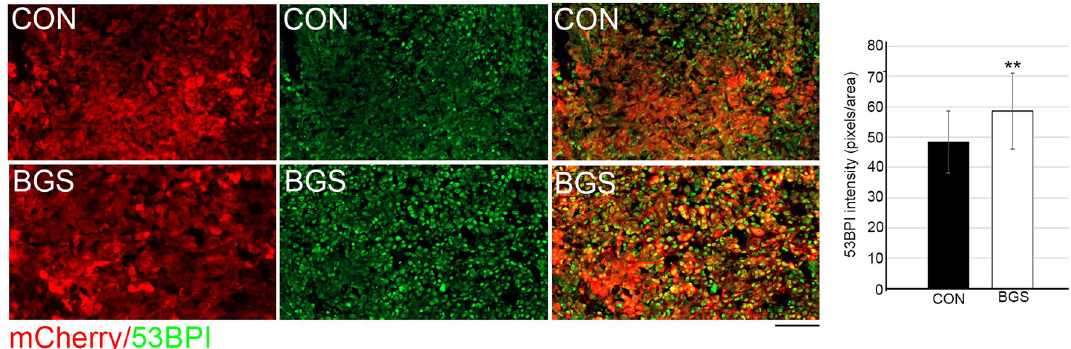
Figure 4. BGS treatment increased RET melanoma cell DNA damage. Representative images of the control and BGS treatments for 53BP1 DNA damage and tumor suppressor marker expression (green) in the tumor (mCherry). 53BP1 density is significantly increased in the BGS-treated group compared to the control group. Results are presented as mean ± SD (n = 7 animals/group; **p < 0.01). Scale bar 200 µm.